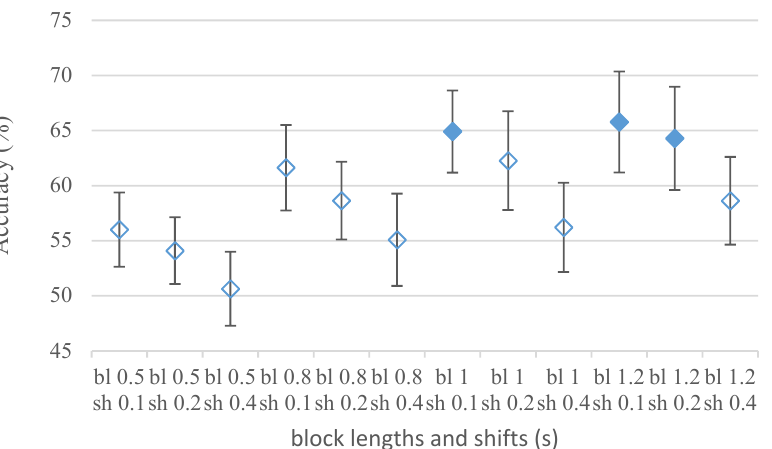
Figure 4. Averaged accuracies and standard deviations for 0.5, 0.8, 1, and 1.2 s block lengths (bl) with 0.1, 0.2, and 0.4 s shifts (sh) between adjacent blocks and an 8 kHz maximal frequency. Filled marks show equally performing